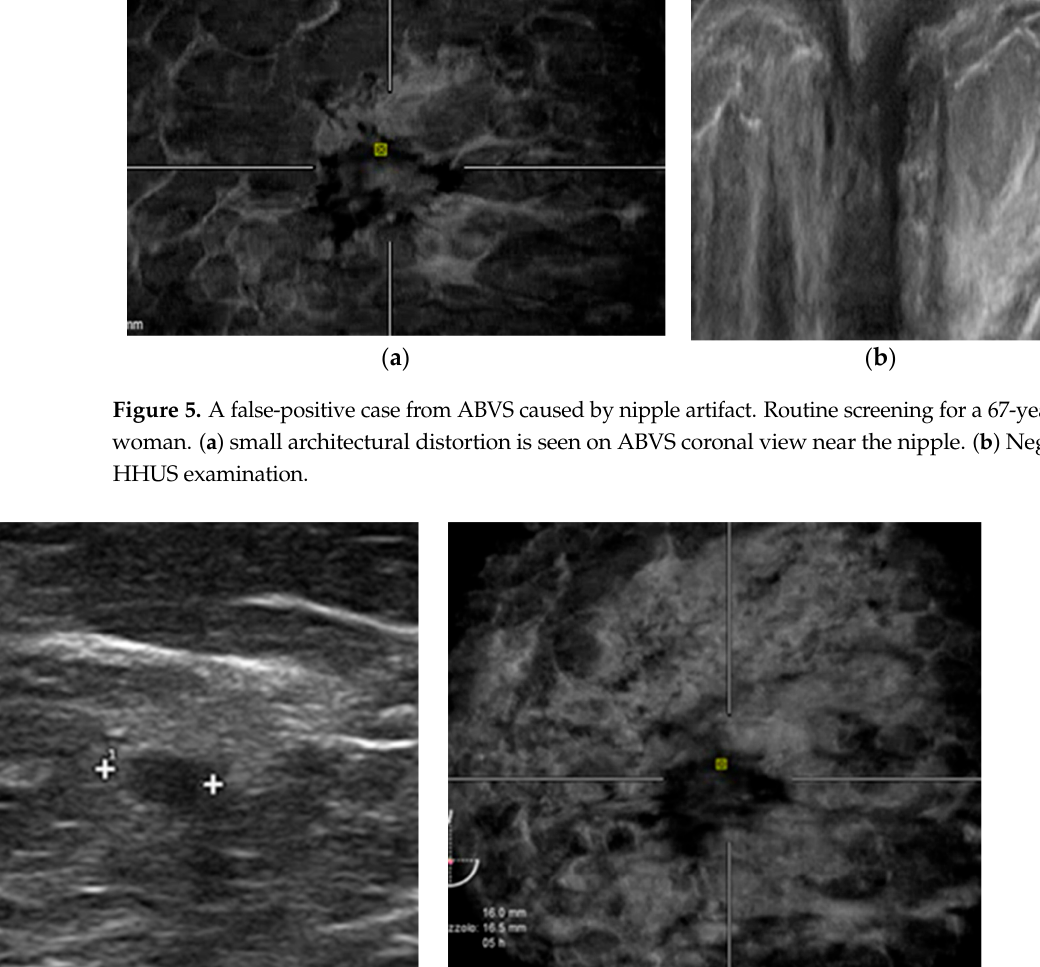
Figure 6. 44-year-old woman comes to our institute for her first mammography. HHUS ( a ) shows a small nodule (triple negative invasive ductal carcinoma). Instead, there was a negative ABVS exam- ination ( b ).